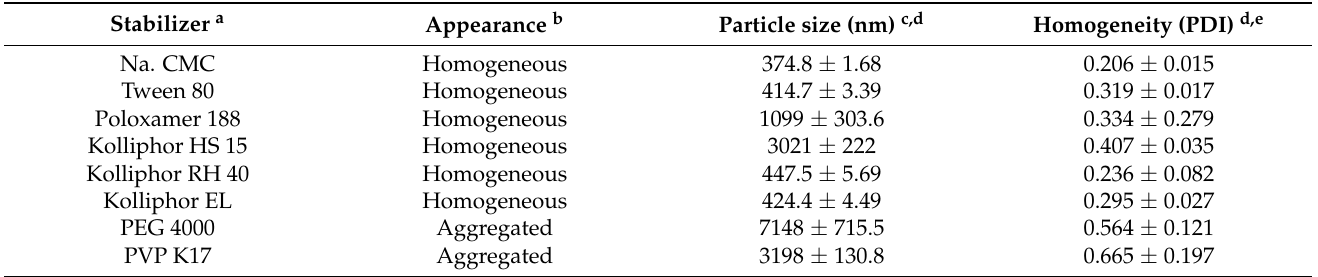
Table 1. Assessment of suspending agent on dispersibility, particle size, and homogeneity of RTG crystals in aqueous vehicle.